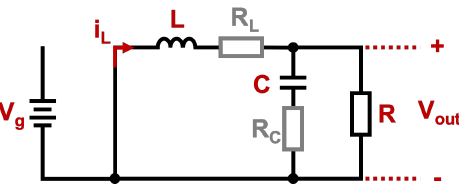
Figure 10. Buck converter equivalent model when the transistor is